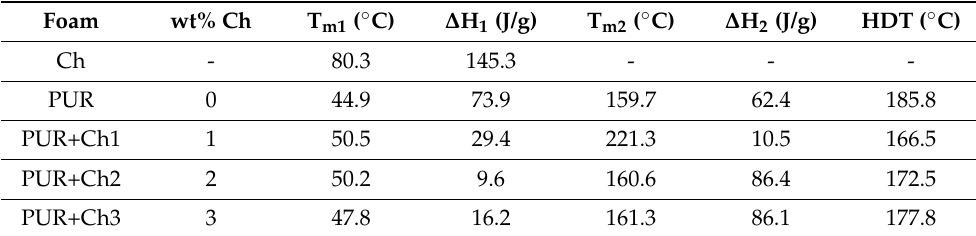
Table 4. Melting temperature and enthalpy of soft (T m1 , ∆ H 1 ) and hard (T m2 , ∆ H 2 ) segments and heat deflection temperature (HDT) of PUR and PUR+Ch foams.